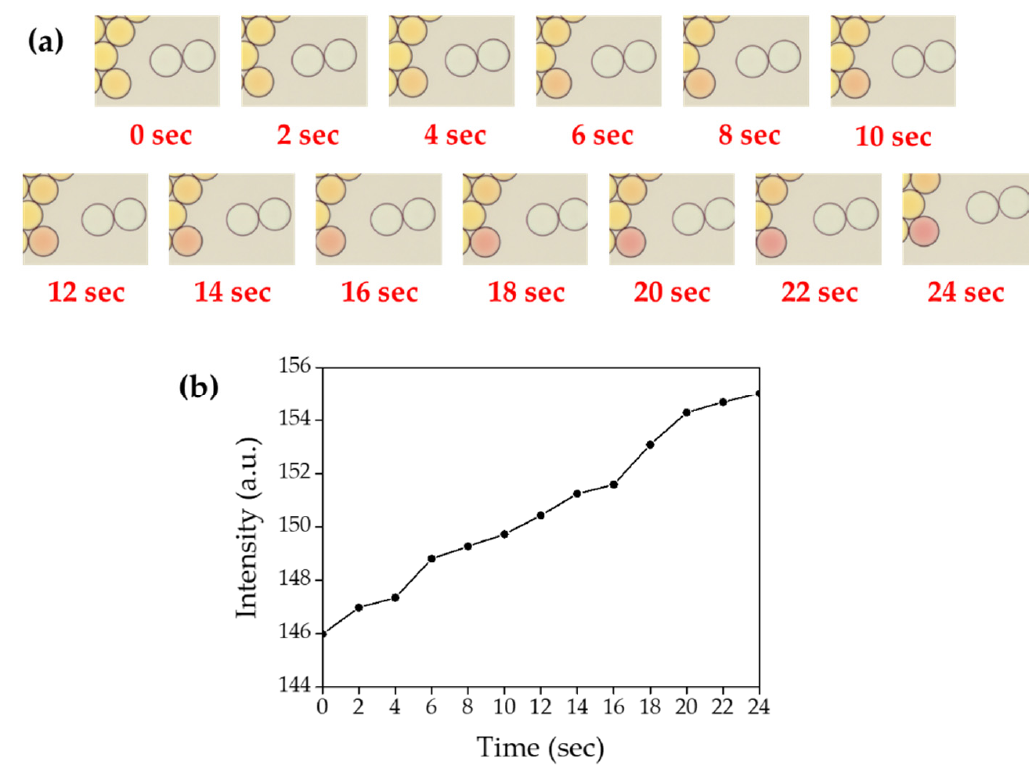
Figure 16. Time-course measurement of ammonia gas crosstalk between droplets. ( a ) Microscopic images of droplet mixture between indicator droplet and ammonia gas generating droplets, the video was recorded for 24 s under a DMi-8 microscope. ( b ) Mean values of color change in the indicator droplets.